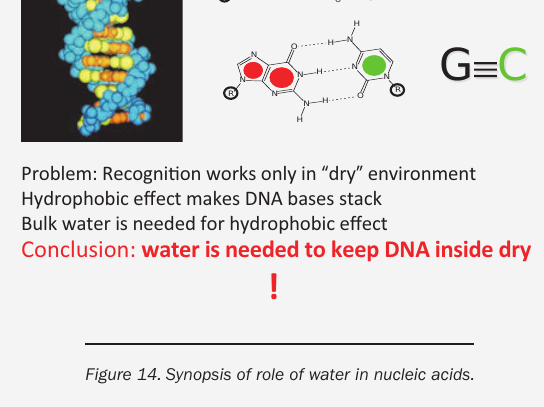
Figure 14. Synopsis of role of water in nucleic